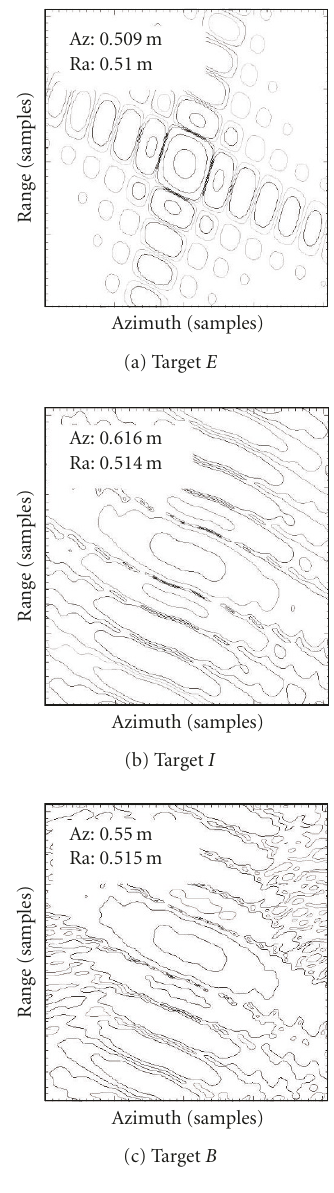
Figure 4: Resolution analysis after processing with the original ( ω , k )-algorithm (squint angle = 20 ◦